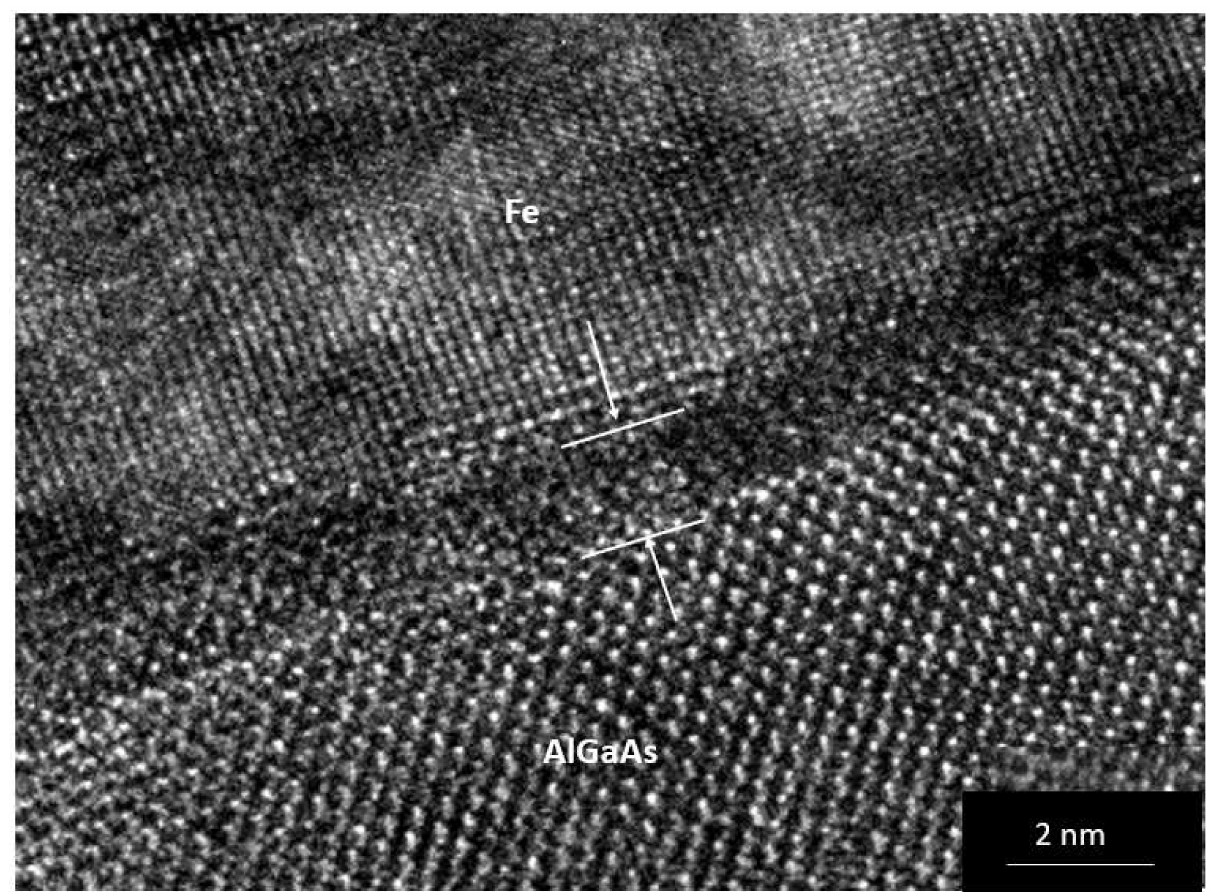
Figure 9. A HRTEM image showing the structure of the film and interfaces of the room-temperature- grown sample upon annealing at 200 ◦ C. It can be observed that the interface is not